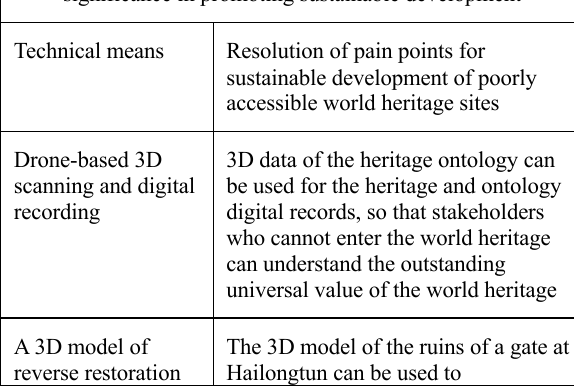
Table 1: Six technical methods and their